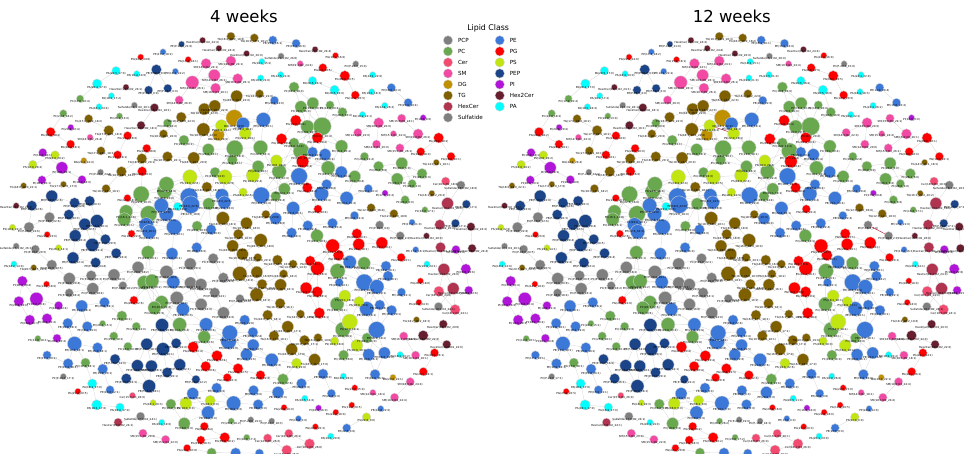
Figure A4. Lipid networks of the lipidomics data from Tu et al. [19]. Nodes are colored by lipid class and edges show correlations between lipids for each mouse age group. Significant and negative correlations are blue, significant and positive correlations red, and insignificant correlations gray. Other time points show similarly less significant correlations (not shown here).